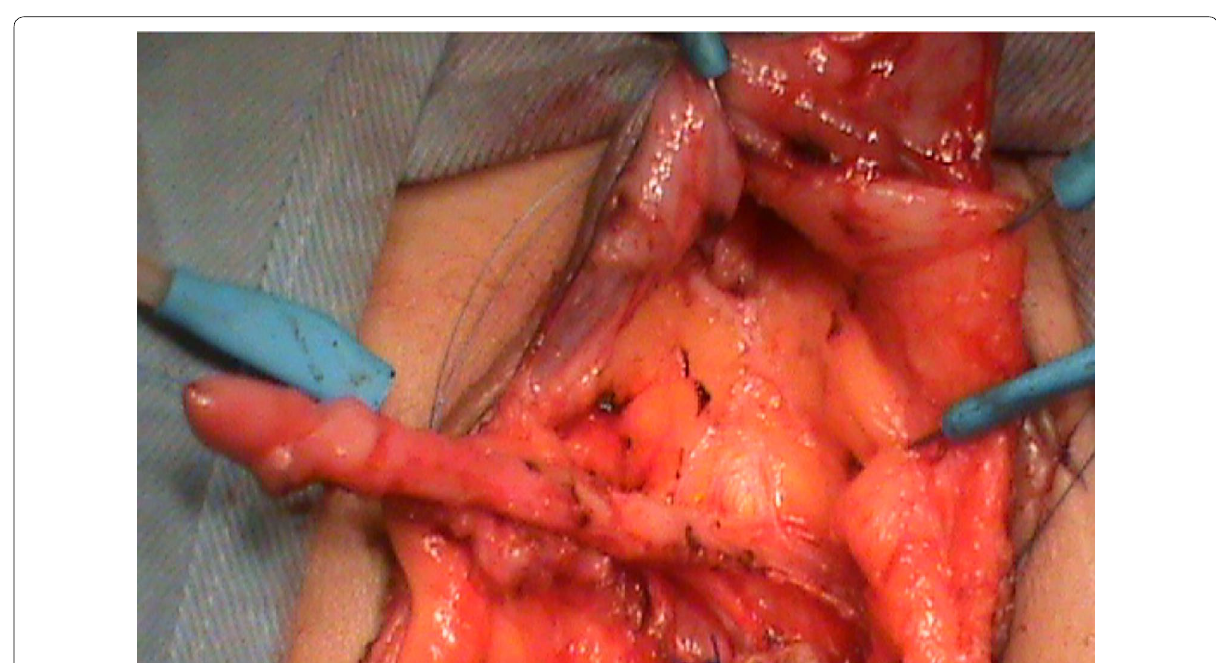
Fig. 2 Full dissection of the neurovascular bundle of the glans clitoris and excision of the body of clitoris after control of the crura of body clitoris